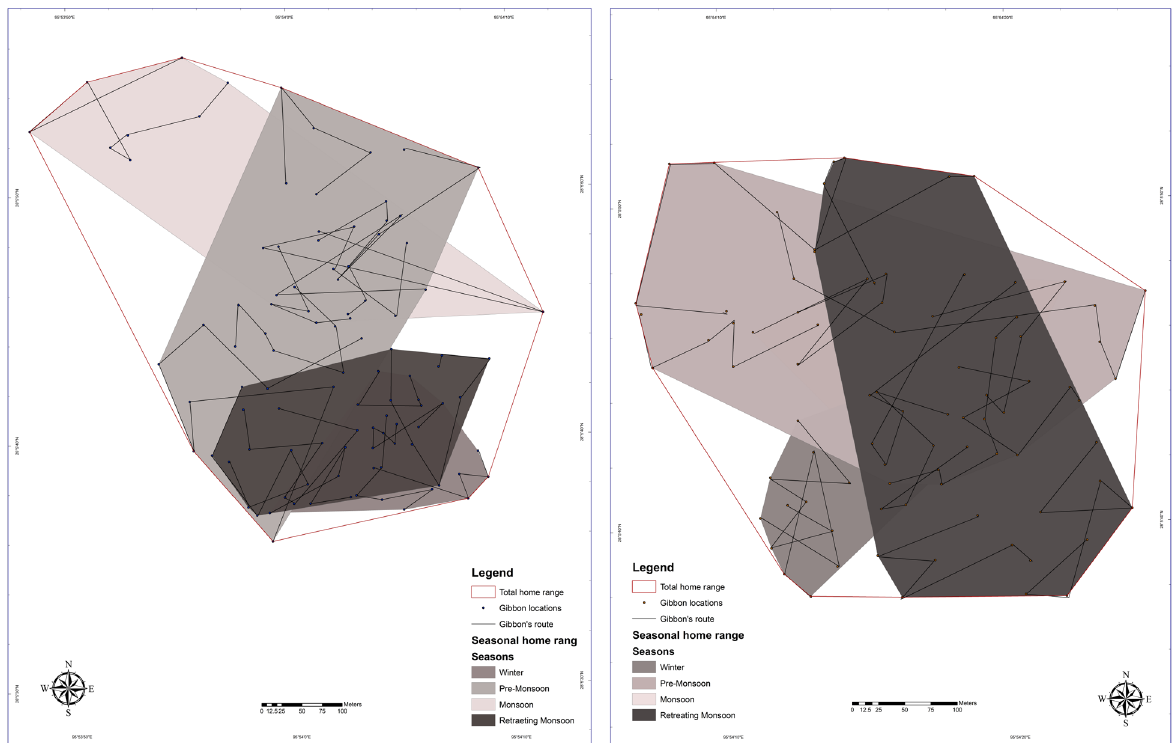
Figure 3b. Home range of Group D (left) and Group E (right) showing seasonal pattern in different